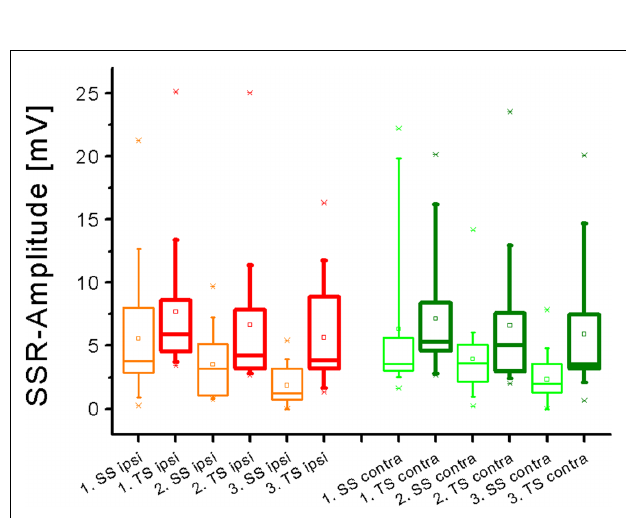
FIGURE 1 | Representative SSR recordings obtained after single stimuli (A) and triple stimuli (B) over the right superficial radial nerve at the wrist of the same subject.